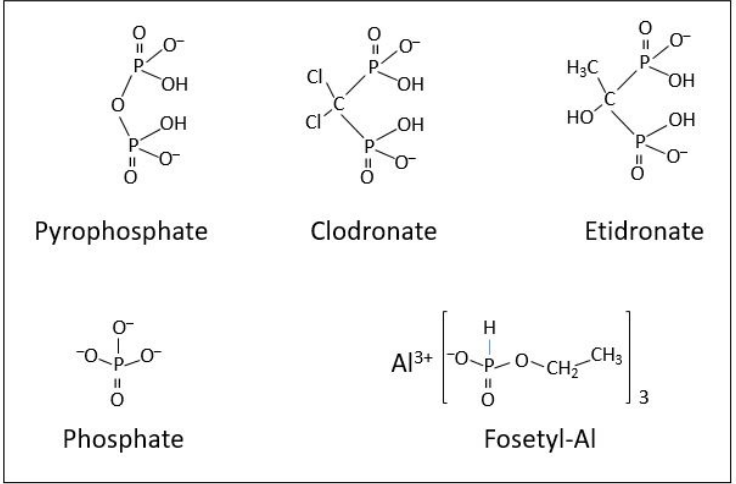
Figure 3. Structures of inorganic pyrophosphate and inorganic phosphate, along with their phosphonate analogs that were used in this study.